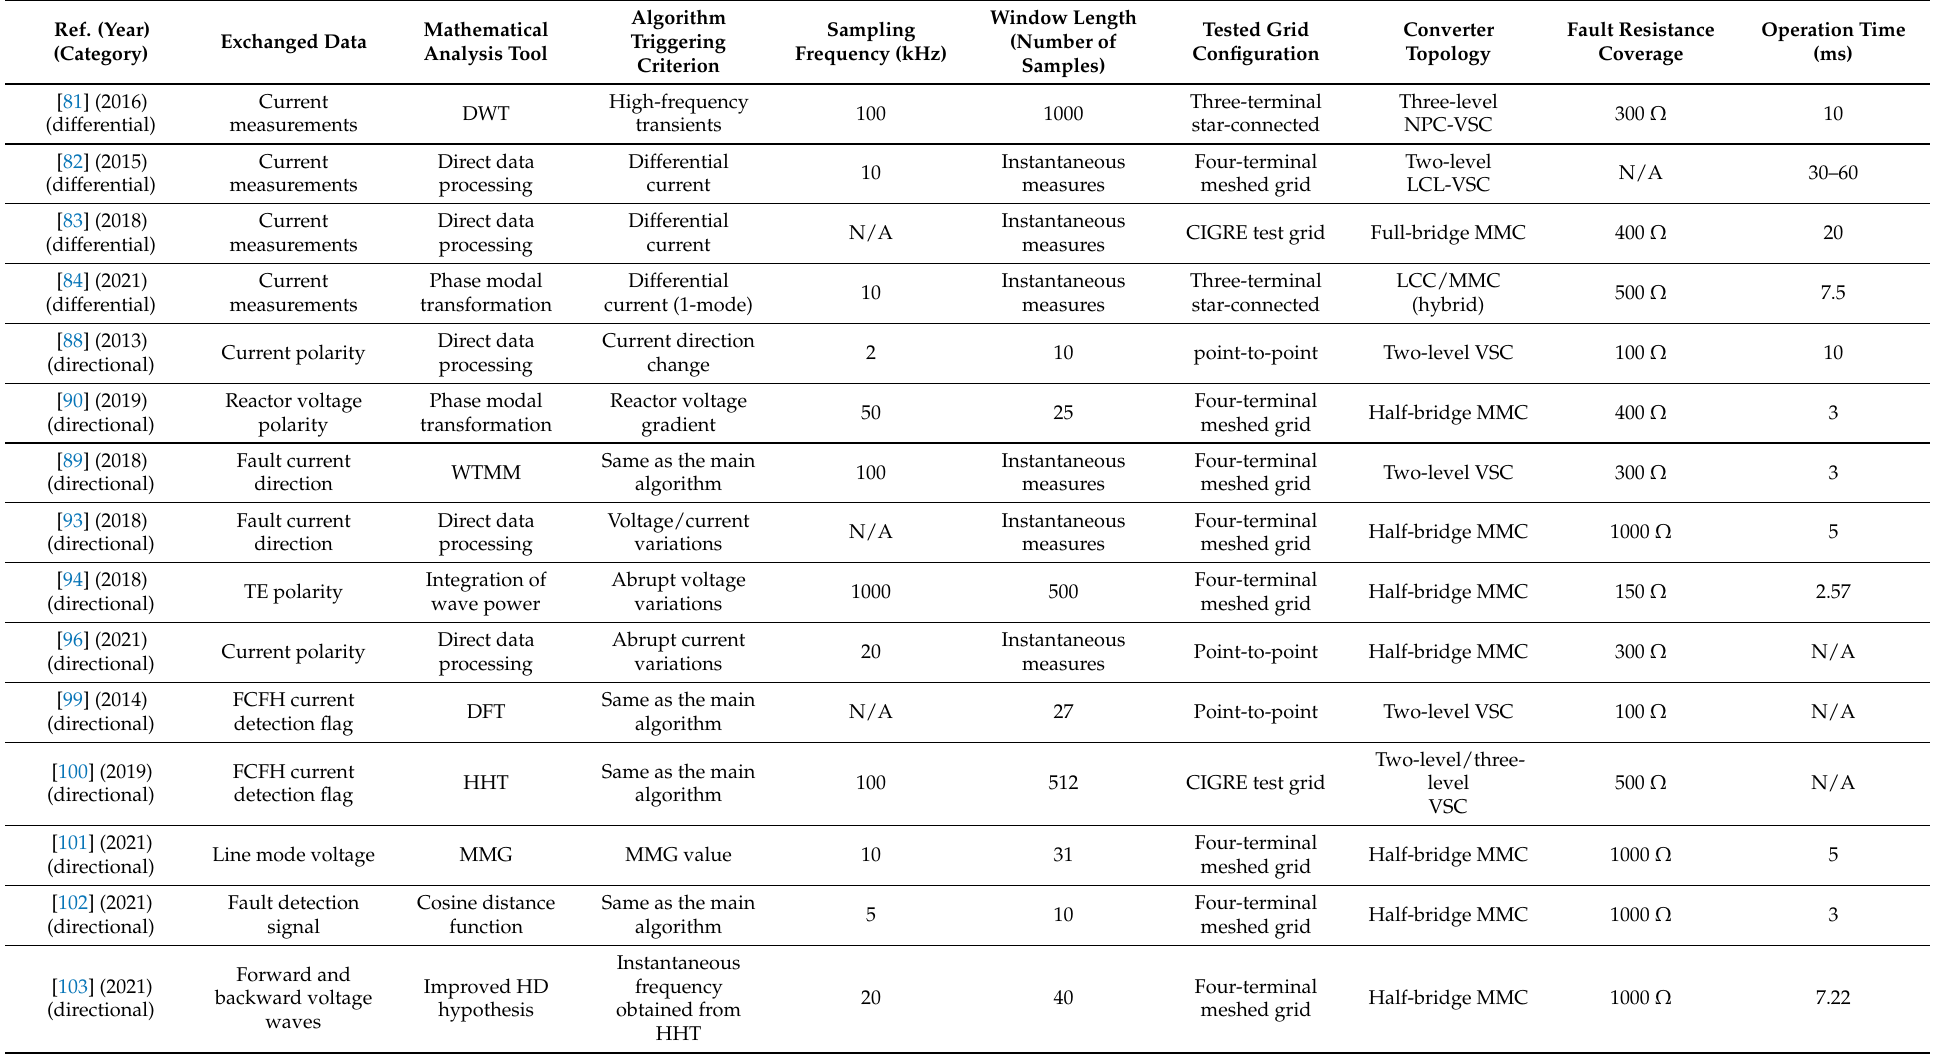
Table 4. Comparison among various communication-based protection